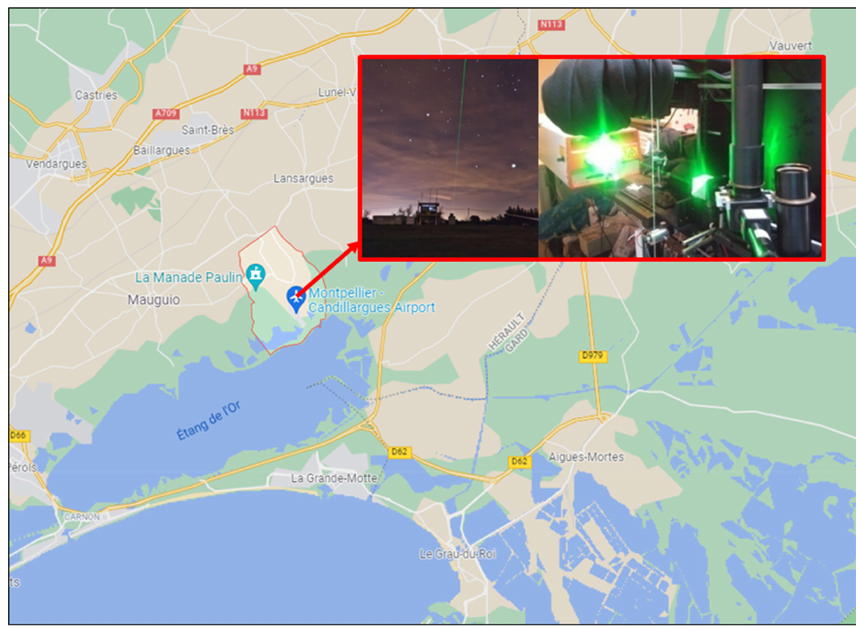
Figure 1. Location and two images of the Raman lidar system BASIL operated during HyMeX-SOP1 (©Google Maps